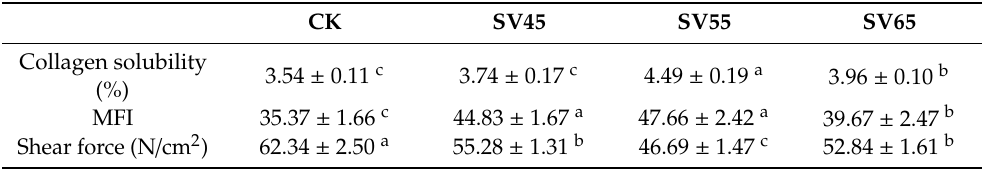
Table 1. E ff ect of SV treatment on collagen solubility, MFI and shear